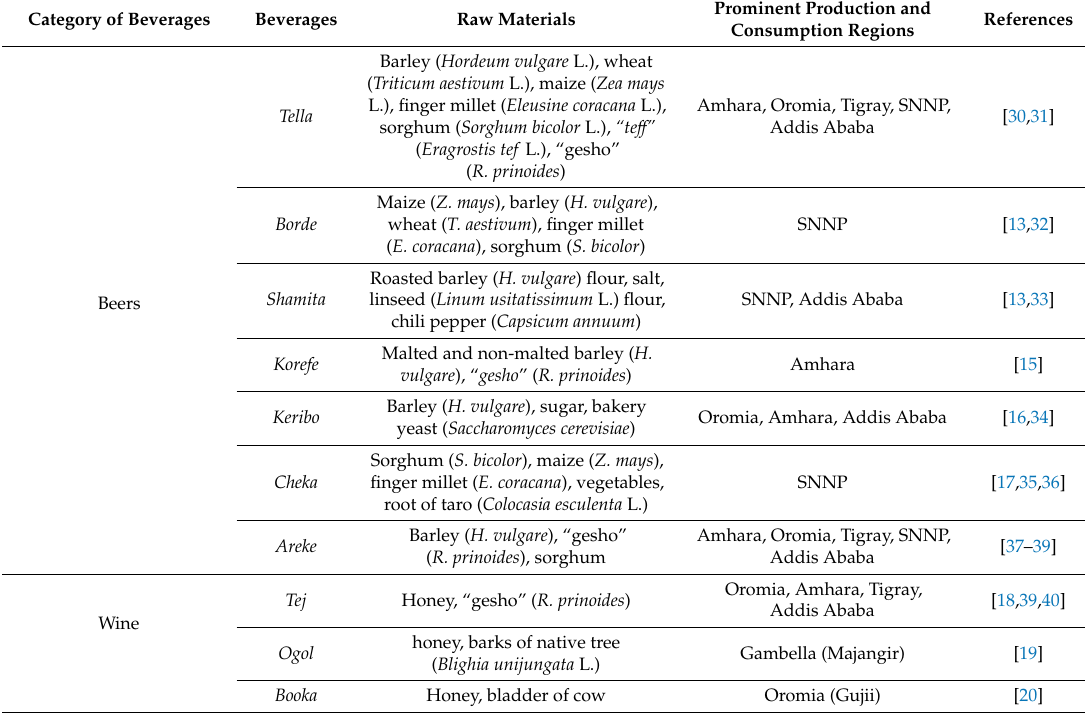
Table 1. Summary of cereal- and fruit-based Ethiopian traditional fermented alcoholic